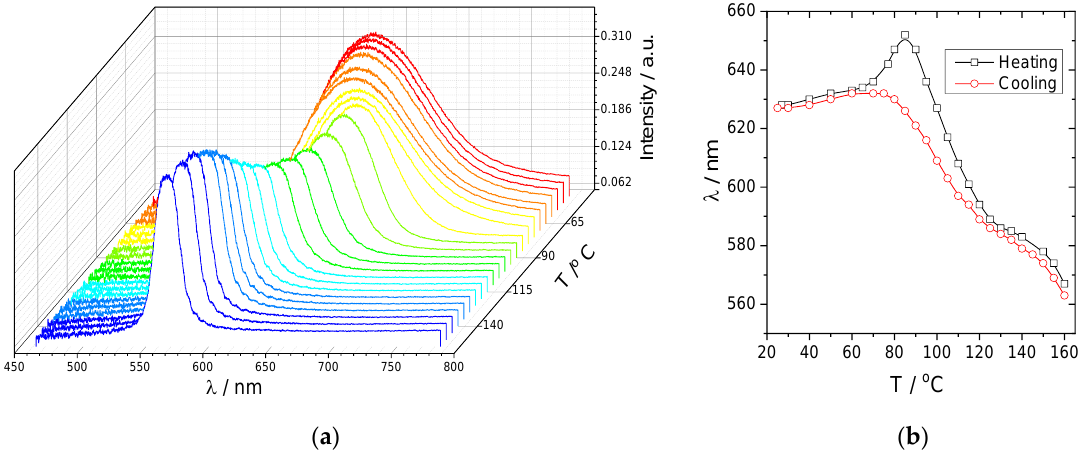
Figure 2. ( a ) Reflection spectra of a planarly oriented film of the mixture recorded upon heating. ( b ) Temperature dependences of the maximum of the selective light reflection recorded during heating and cooling. The rate of the temperature change is 1 °C/min.